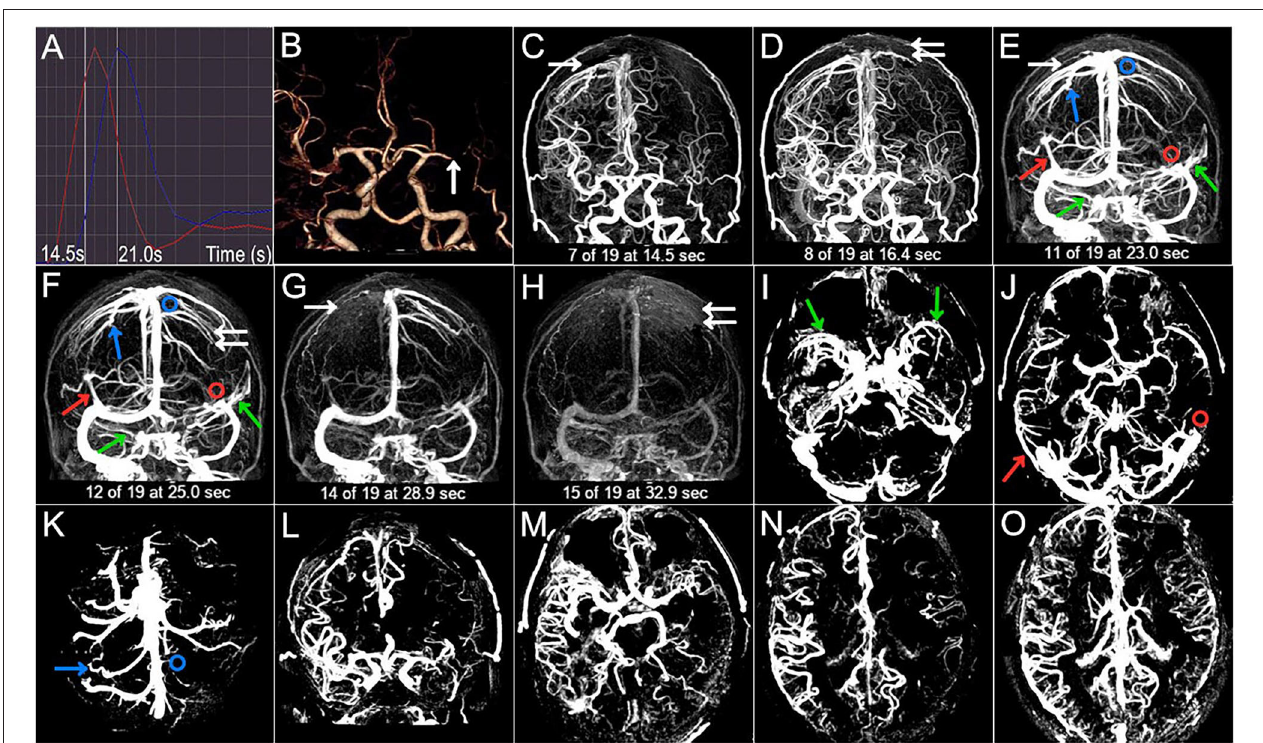
FIGURE 3 | Case 3. A 50-year-old man with a history of hypertension, diabetes, and smoking presented with dysarthria and right-sided hemiparesis. NIHSS score was 6 on admission and 3-month mRS score was 3 (poor outcome). (A) The selected arterial phase and the venous phase are 14.5s and 21.0s, respectively. (B) The arrow points to the left M1 occlusion. (C–H) The CVF 1 , CVF 2 , CVF 3 , CVF 21 , and CVF 31 of the contralateral hemisphere (white arrow) are 14.5s, 23.0s, 28.9s, 8.5s, and 14.4s, respectively, while CVF 1 , CVF 2 , CVF 3 , CVF 21 , and CVF 31 of the affected hemisphere (double white arrow) are 16.4s, 25.0s, 32.9s, 8.6s, and 16.5s, respectively. The mean difference between the affected and contralateral hemisphere is 0.1s for rCVF 21 . (C–K) SMCV-, VOL-, and VOT- are not found in the contralateral hemisphere (color arrow), while VOL- (red circle) and VOT- (blue circle) are shown in the affected hemisphere. (L–O) Compromised antegrade flow and poor collateral status.